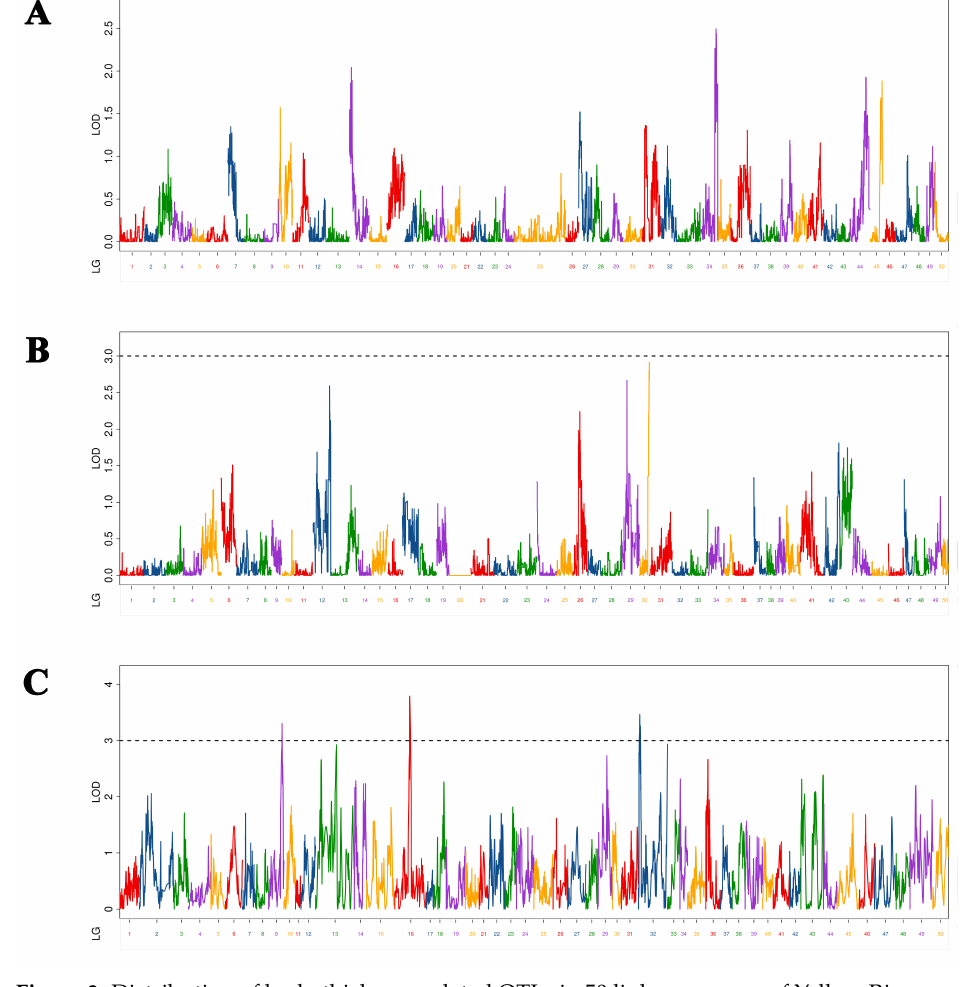
Figure 3. Distribution of body thickness-related QTLs in 50 linkage groups of Yellow River carp in the maternal ( A ), paternal ( B ), and HH maps ( C ). Different color indicates different linkage group.